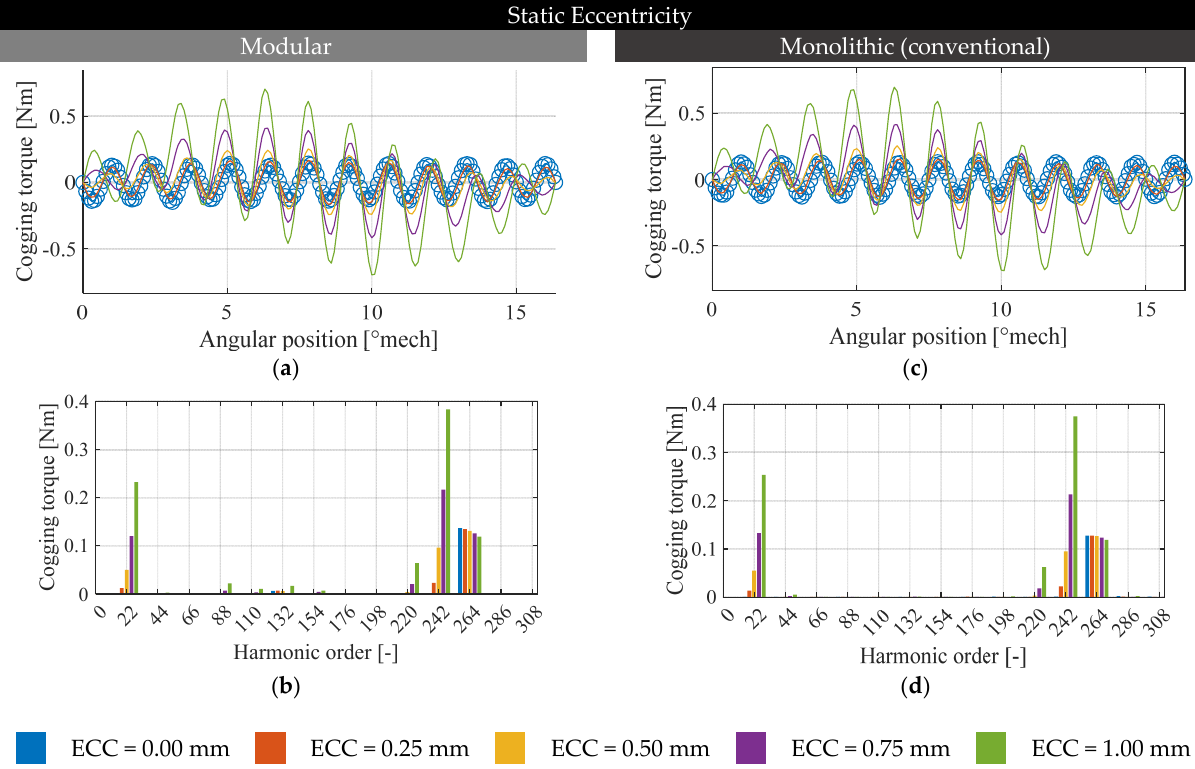
Figure 7. FE evaluation of cogging torque in the presence of SE for 24-slot, 22-pole PMSM and MPMSM: ( a ) cogging torque waveform for the modular machine, ( b ) cogging torque spectrum for the modular machine, ( c ) cogging torque waveform for the monolithic machine, ( d ) cogging torque spectrum for the monolithic